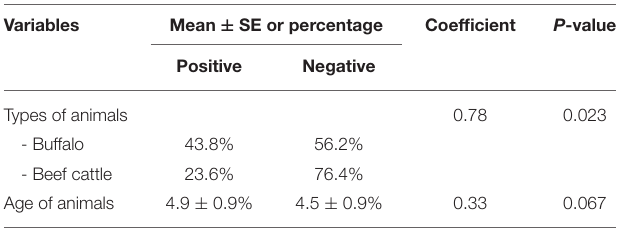
TABLE 3 | Univariate analysis of variables as P ≤ 0.2 considered for multivariate analysis.